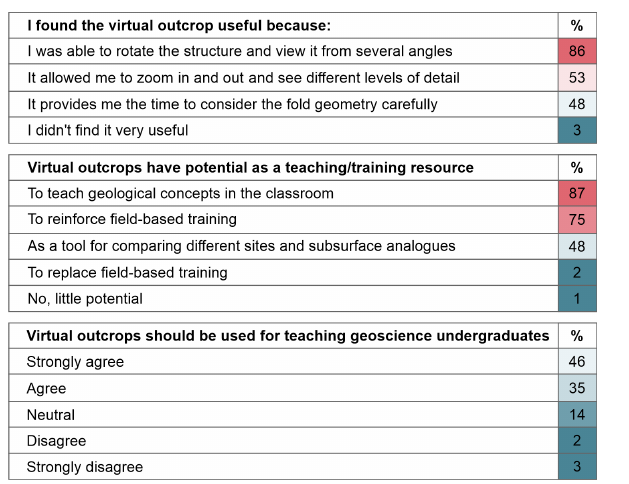
Figure 6. Responses, summarised as percentages, from both co- horts to question on virtual outcrop use and value for